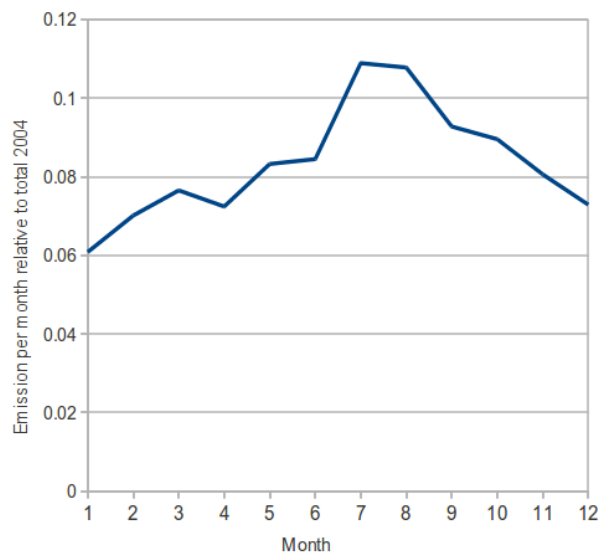
Fig. 1. Shipping emissions within AMAP per month, relative to total shipping emissions within AMAP in